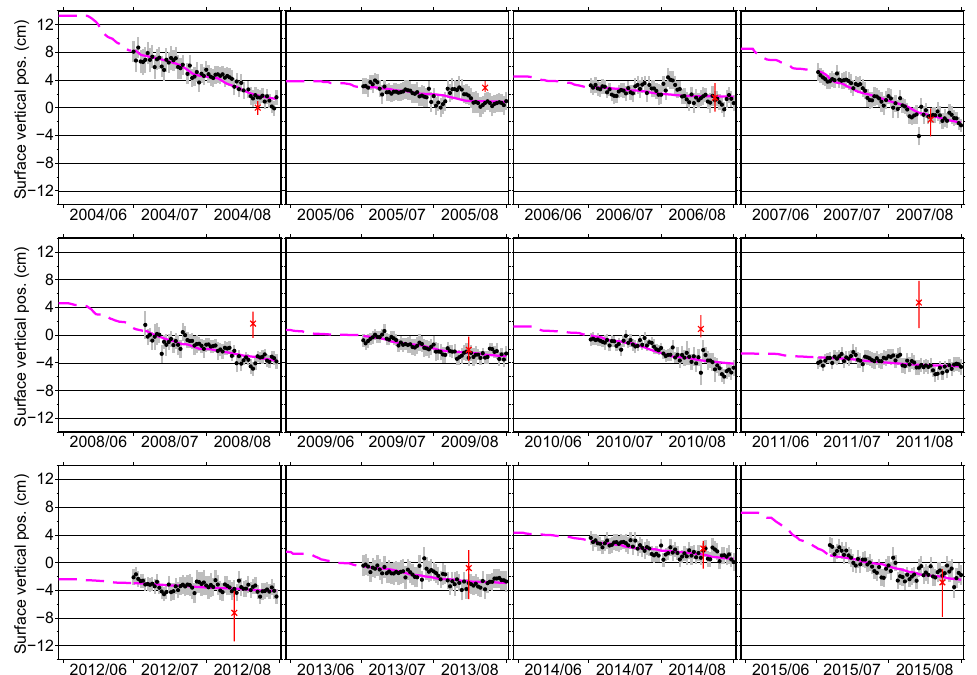
Figure 5. Similar to Fig. 4a, but showing the time series in each year from 2004 to 2015. The solid magenta lines are the best fit seasonal changes of surface elevation using Eq. (5). The dashed magenta lines denote the extended records back to 1 June.